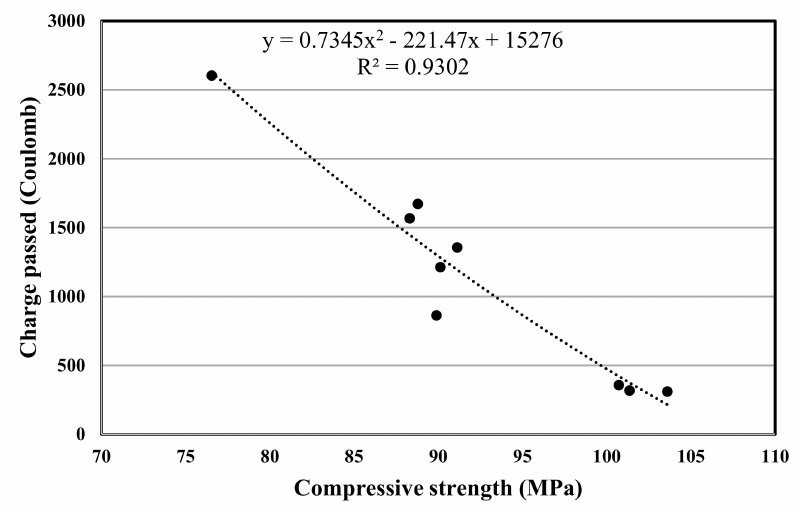
Figure 7. Correlation between compressive strength and the total charge passed.